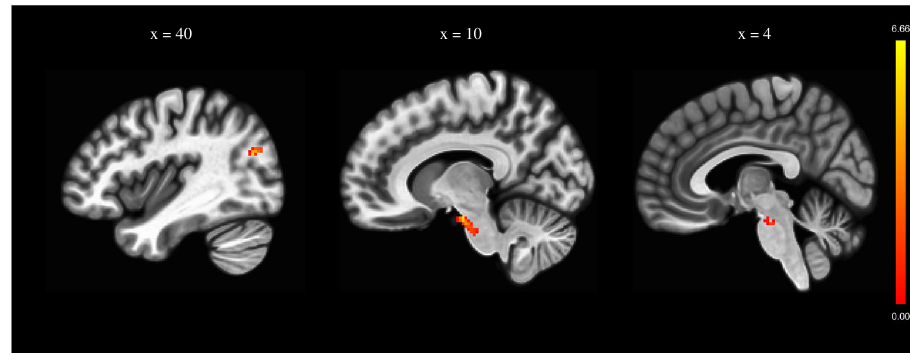
Fig. 2 Biological effects of iTBS on brain connectivity. Brain regions with signi fi cant changes in resting-state functional connectivity (rsFC) with the left dorsolateral prefrontal cortex after 20 sessions of active intermittent theta burst stimulation (iTBS, N = 10) compared to sham iTBS ( N = 7). The rsFC changes (post-iTBS minus pre-iTBS) were compared between the active and sham groups using two-sample T tests. The results were thresholded at an uncorrected voxel-level threshold of p <.001 with an FWE-corrected p <0.05 (minimum K =